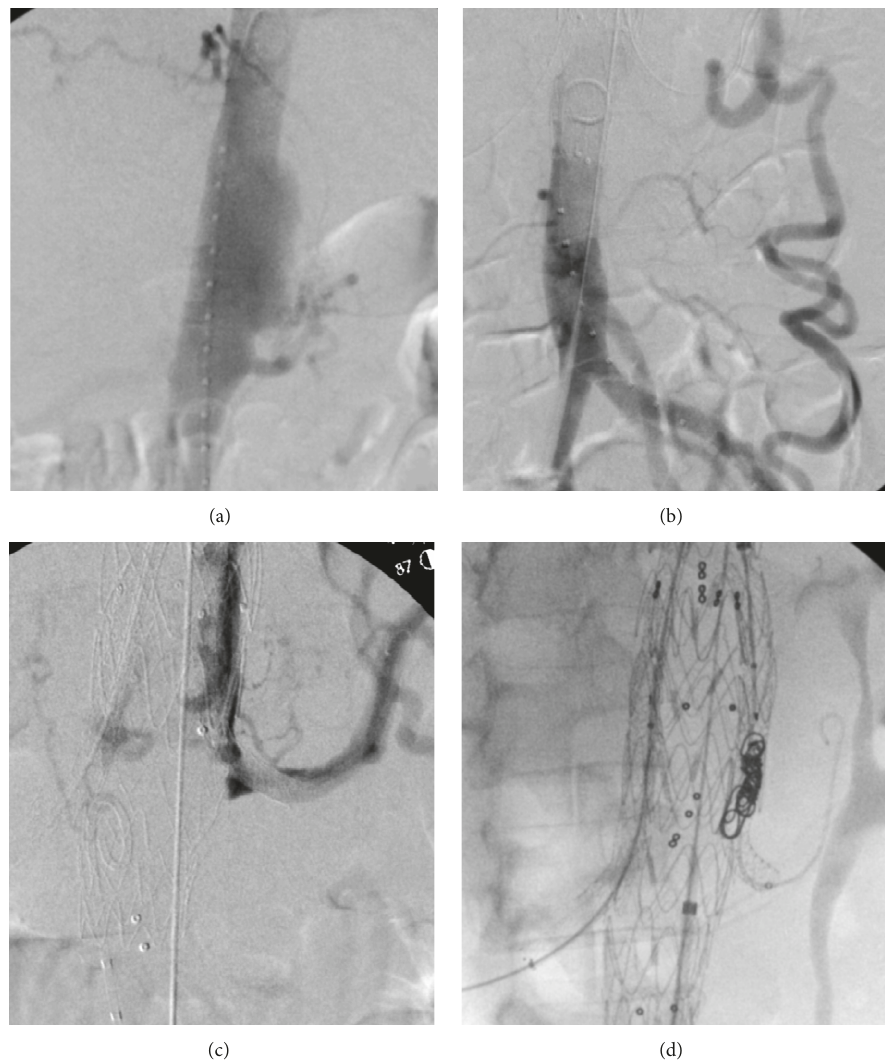
Figure 3: Intraoperative angiogram shows suprarenal saccular aneurysm with nearly occluded celiac and superior mesenteric artery (a). Large patent of inferior mesenteric artery gives blood supply to whole abdomen (b). Endoleak type III from left gutter (c). Extended gutter and coil embolization between left renal stent and aortic stent